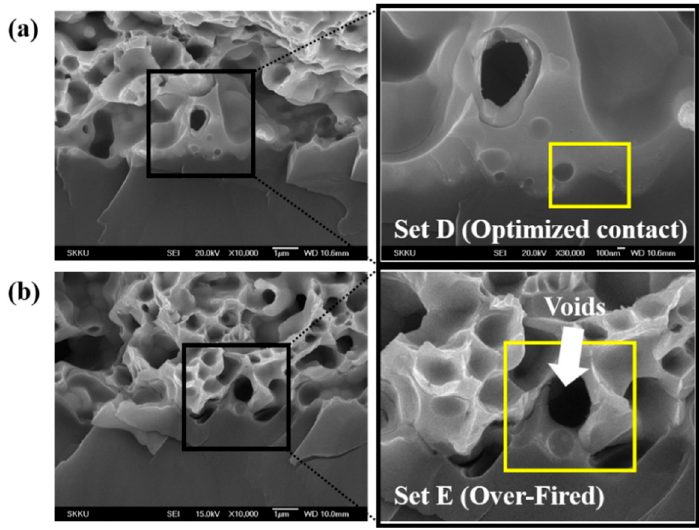
Figure 5. SEM images of the cross-sections of metal electrode formed on a pyramid structure for co-firing temperature profile for ( a ) set D and ( b ) set E.